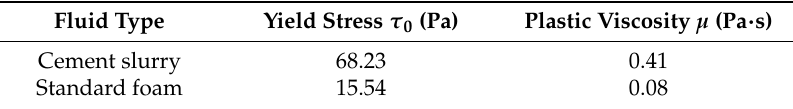
Figure 5. Rheological properties of the cement slurry and standard foam: ( a ) evolution of shear stress with share rate and ( b ) evolution of plastic viscosity with share rate. Table 1. The rheological properties of the cement slurry and standard